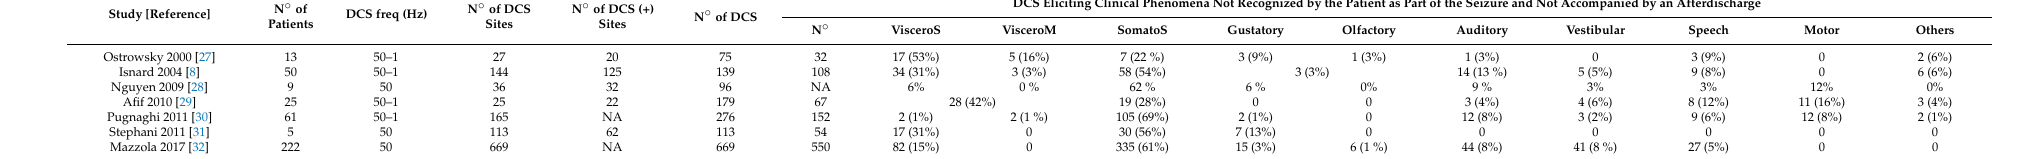
Table 1. Functional mapping studies of the insula. Percentages were rounded to the nearest whole number (downward when the fraction was less than 0.5 and upward when the fraction was 0.5 or greater). Note that the percentages do not total 100%, since one single DCS can produce several types of clinical responses simultaneously. NA: not available; N ◦ : number; DCS: direct cortical stimulation; DCS (+): DCS eliciting clinical signs; freq: frequency; VisceroS: viscerosensitive; VisceroM: visceromotor; SomatoS: somatosensory. Neurovegetative symptoms were classified as visceromotor when not further